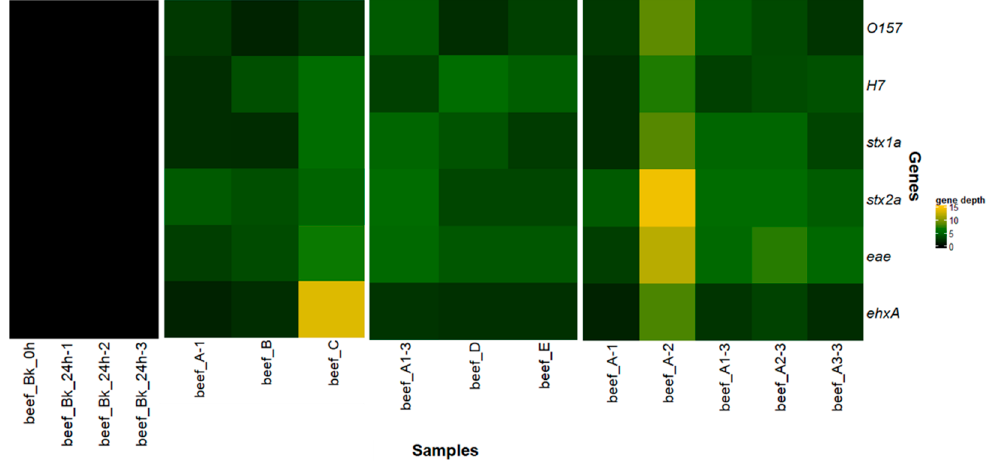
Figure 4. Gene depth per million trimmed reads per sample for the detection of genes encoding for serotype O157:H7 ( wzx and fliC genes) and the stx1a , stx2a , eae, and ehxA virulence genes (5 genes from ISO/TS 13136:2012 and ehxA present on plasmid pO157) with more than 80% query coverage and 80% identity in all reads for beef samples processed with different workflows A-B-C-D-E, and in biological (A-1, A-2, A-3) and technical replicates (A1-3, A2-3, A3-3) of workflow A. Increasing depth (per million trimmed reads) is represented in shades of green to yellow according to the color gradient in the legend.